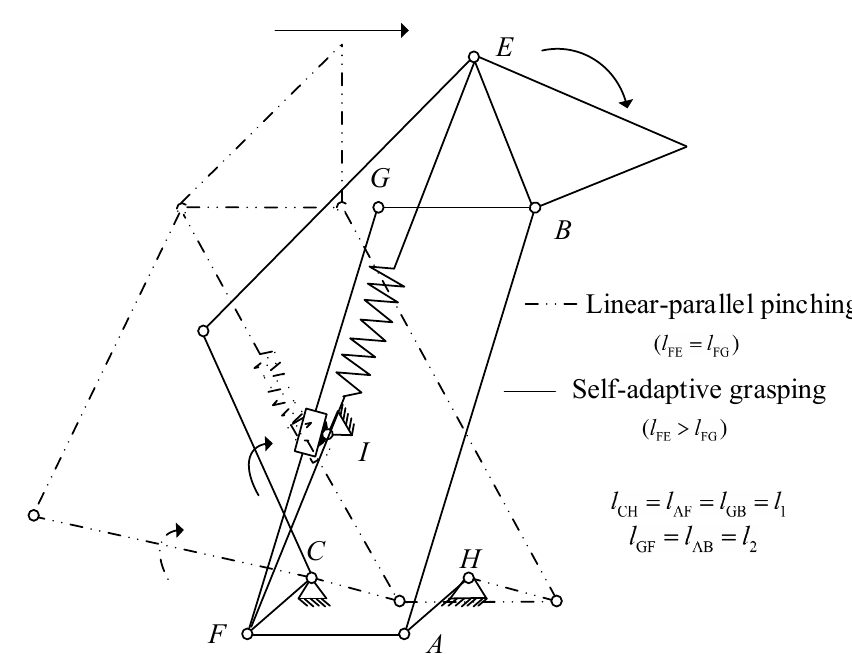
Figure 1. Linear-parallel pinching and self-adaptive grasping modes.